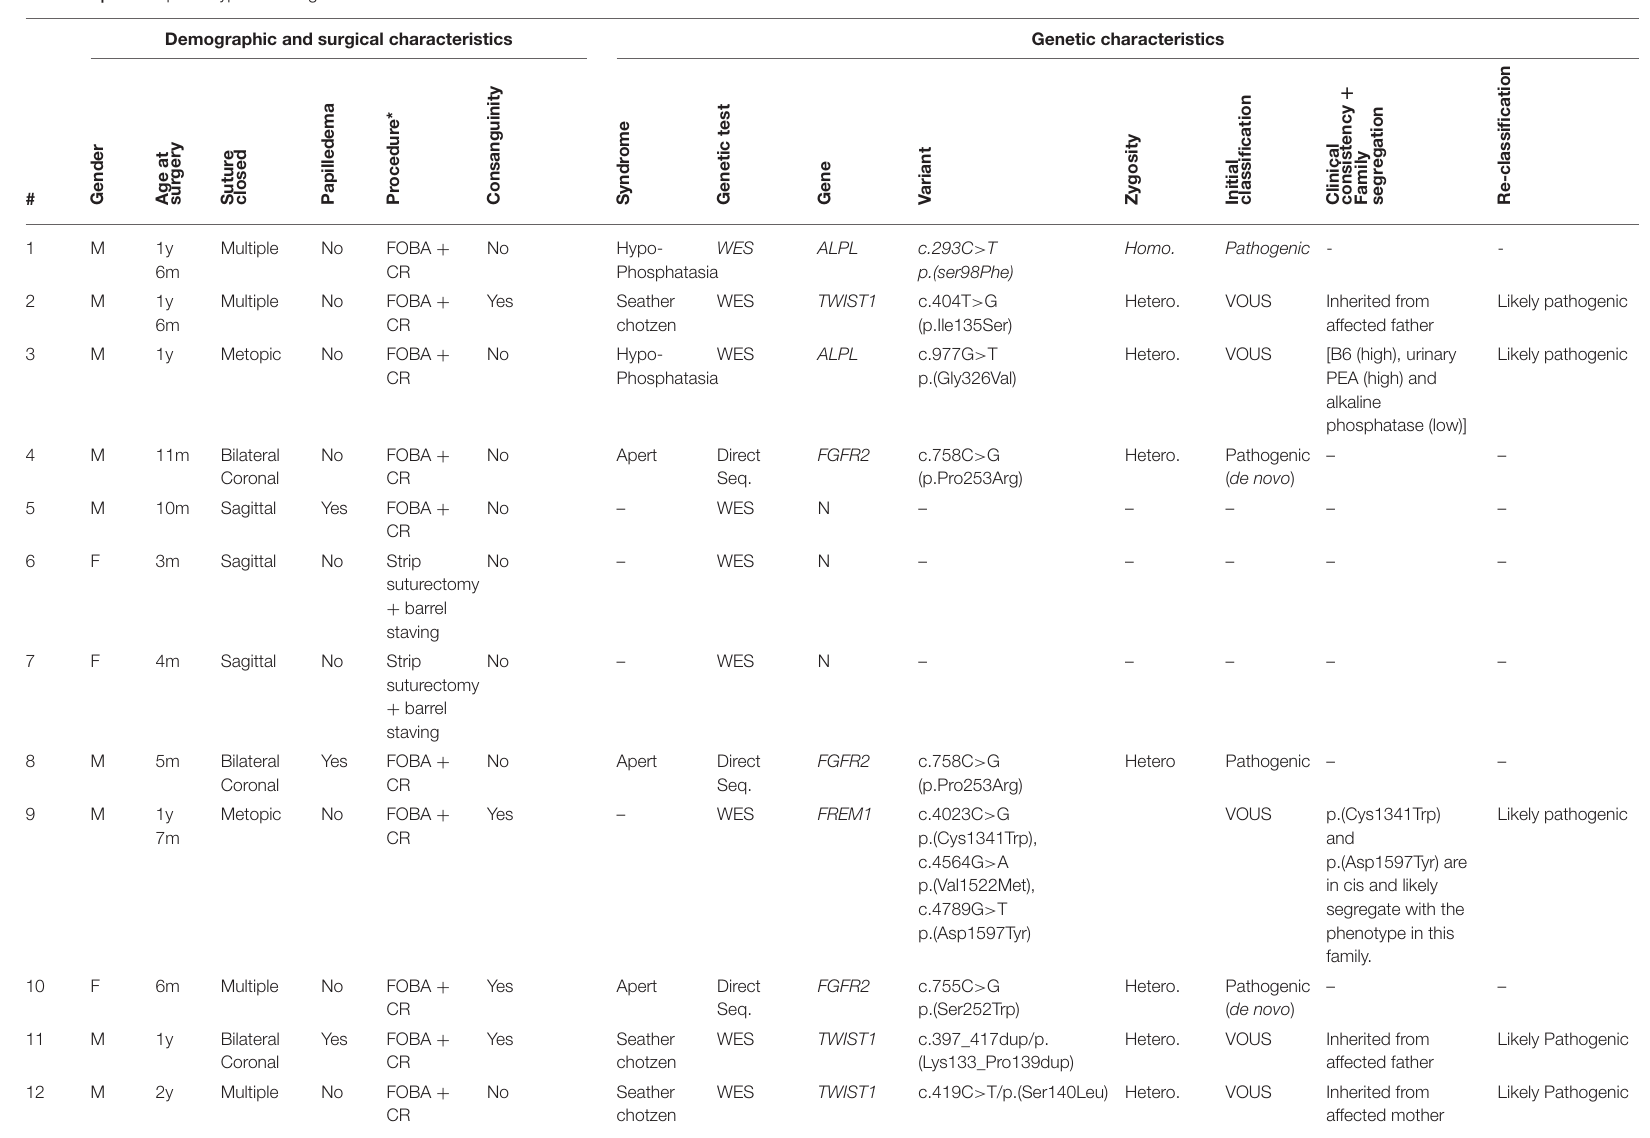
TABLE 1 | Patient phenotype including clinical and molecular